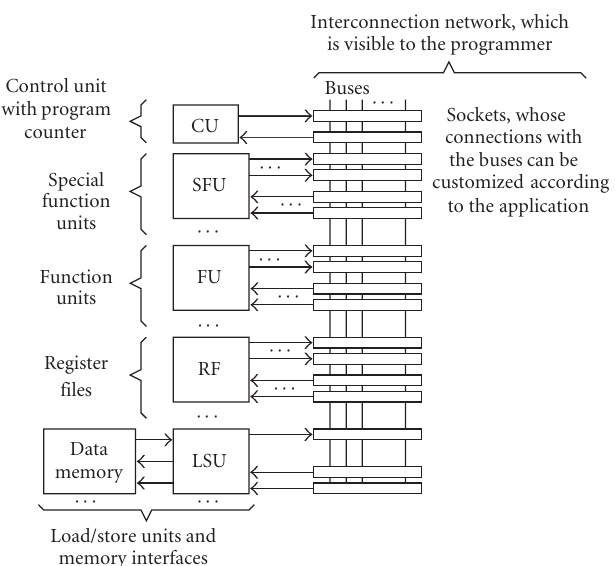
Figure 2: TTA processors consist of a CU and variable number of FUs, SFUs, RFs, and LSUs. Unused connections between the resources can be excluded from the interconnection